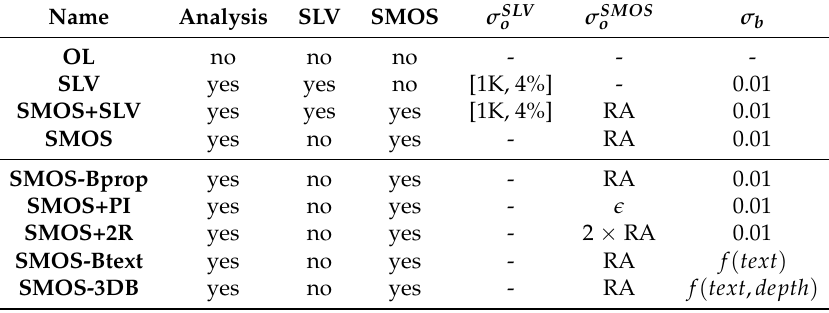
Table 1. Assimilation features of the experiments used in this study. Each column represents the following: (1) experiment name; (2) whether soil moisture is analysed? (3) whether screen level variables (SLV) are assimilated; (4) whether SMOS T B are assimilated; (5) assumed observed error standard deviation for 2 m temperature and 2 m relative humidity [ σ T 2 m , σ RH 2 m ]; (6) assumed SMOS T B observation error standard deviation (RA is the observation radiometric accuracy with typical values between 2.5–3 K), (cid:101) is an infinitesimal number); and (7) assumed background error standard deviation (in m 3 m − 3 ). “ f ” represents a dependency, “ text ” is soil texture, and “ depth ” is the soil